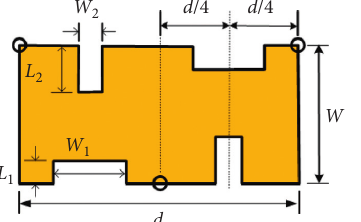
Figure 2: Schematic diagram of the periodic unit structure with length d .